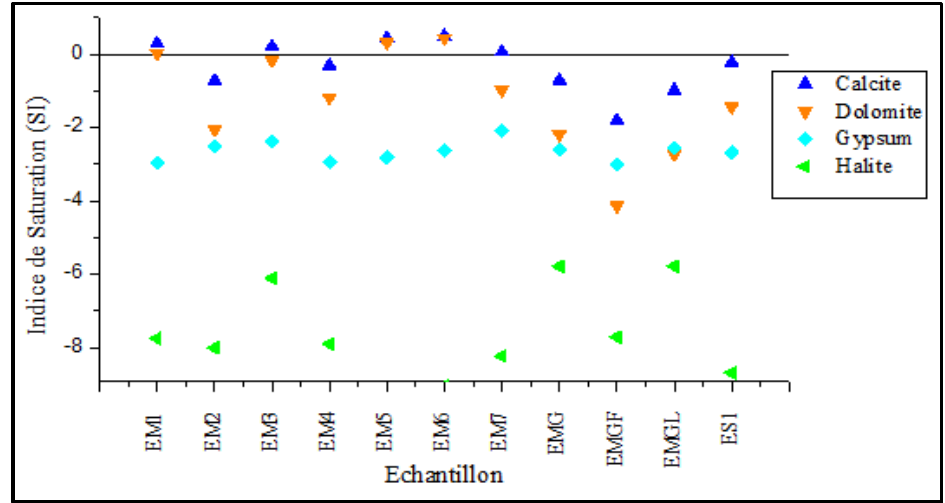
Figure 7. Saturation indices of the different minerals for each sample.